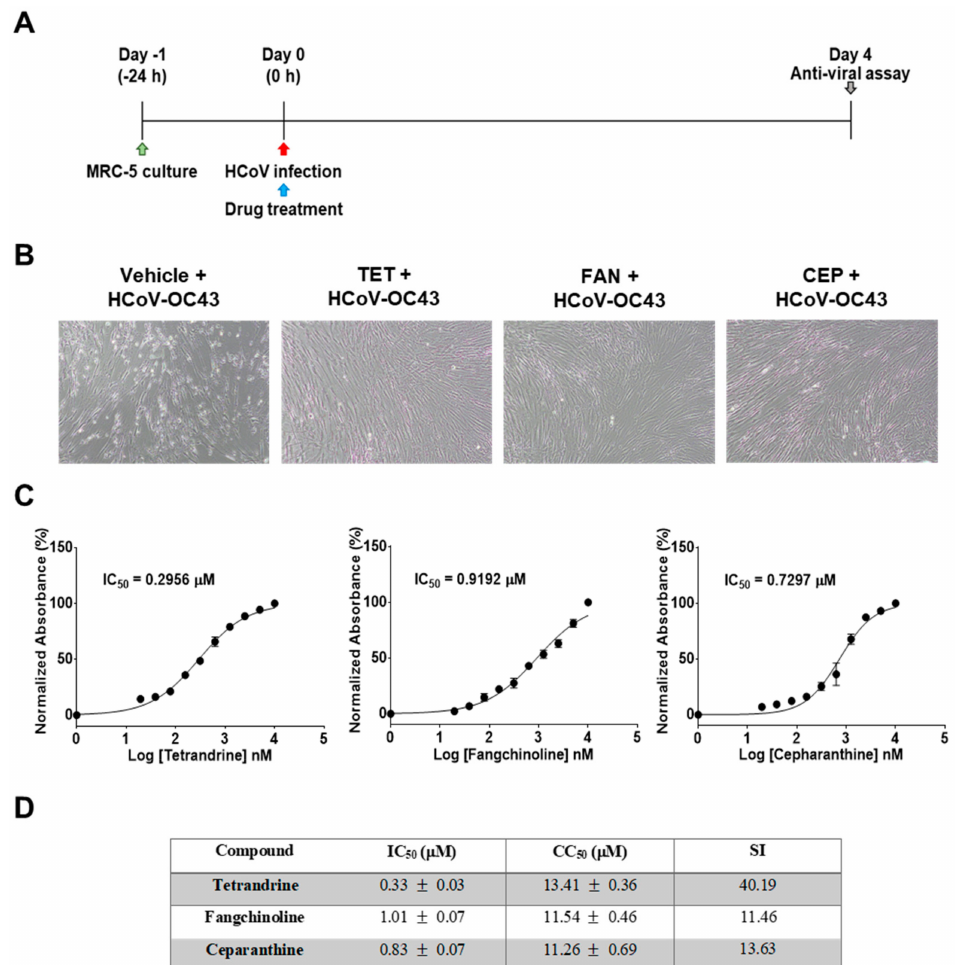
Figure 2. Antiviral activities of TET, FAN, and CEP in MRC-5 cells. MRC-5 cells were infected with human coronavirus (HCoV)-OC43 with or without the addition of two-fold serial dilutions of the compounds. ( A ) Overall scheme for MRC-5 cell infection and treatment with TET, FAN, and CEP. ( B ) Live photo image of MRC-5 at four dpi. ( C ) The inhibitory concentration (IC 50 ) values of the compounds were calculated at four dpi by nonlinear regression analysis. ( D ) Lists the IC 50 , cytotoxic concentration (CC 50 ), and selectivity indices (CC 50 / IC 50 , SI) values. Data are presented as mean ± SEM of three independent